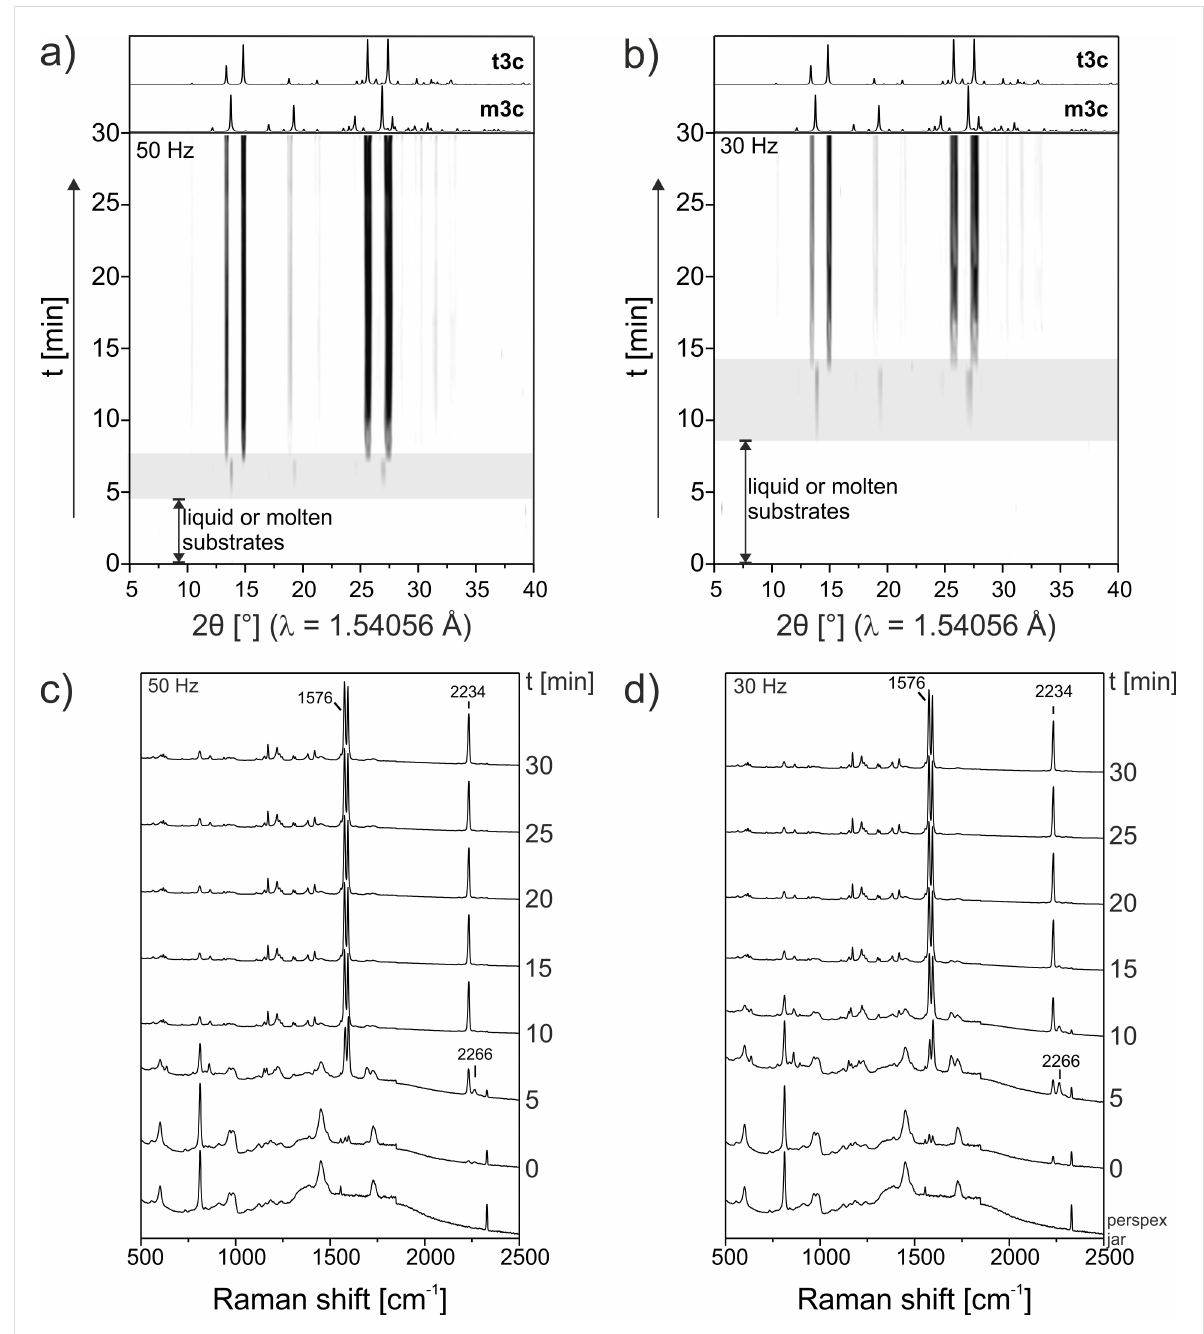
Figure 4: a) In situ XRPD pattern of the mechanochemical Knoevenagel condensation of 1a and 2 with 2 µL catalyst at 50 Hz. Gray box: intermedi- ate phase. b) In situ XRPD pattern of the reaction with a milling frequency of 30 Hz. c) In situ Raman spectra of the mechanochemical Knoevenagel condensation of 1a and 2 with 2 µL catalyst at 50 Hz. d) In situ Raman spectra of the reaction with a milling frequency of 30 Hz. Raman bands: 1576 cm − 1 – C-C stretching vibration; 2234 cm − 1 – C ≡ N stretching vibration of the product; 2266 cm − 1 – C ≡ N stretching vibration of malonodinitrile.